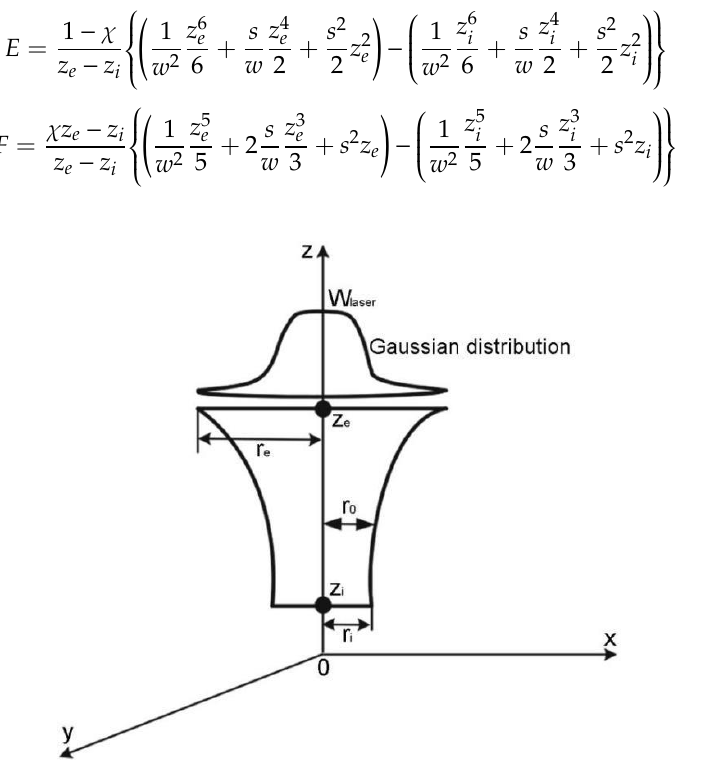
Figure 1. Energy density distribution of the Gaussian body heat source.